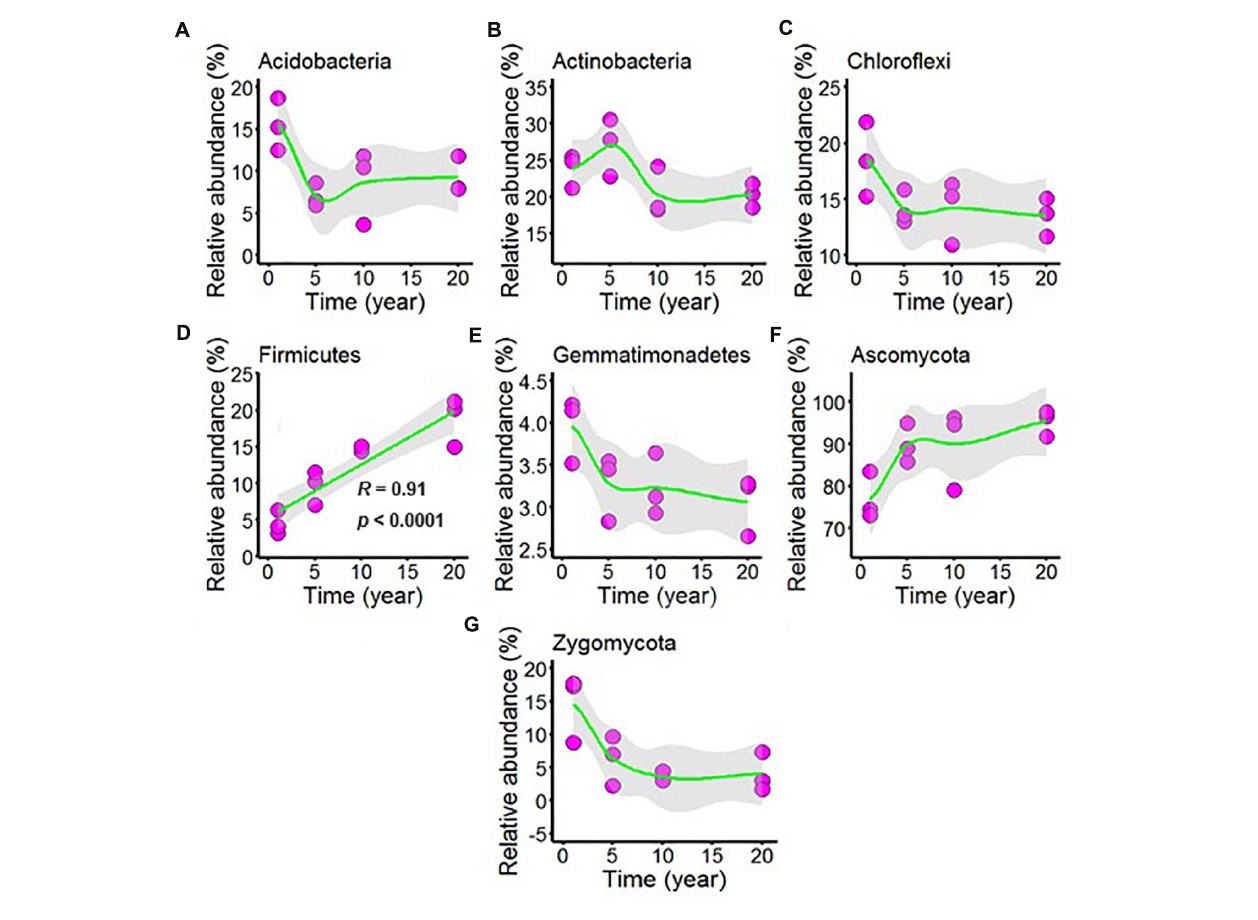
FIGURE 4 | Effect of long-term chili monoculture on the dominant microbes at the phylum level in rhizosphere soil. Long-term chili monoculture altered the relative abundance of Acidobacteria (A) , Actinobacteria (B) , Chloroflexi (C) , Firmicutes (D) , Gemmatimonadetes (E) , Ascomycota (F) , and Zygomycota (G) .